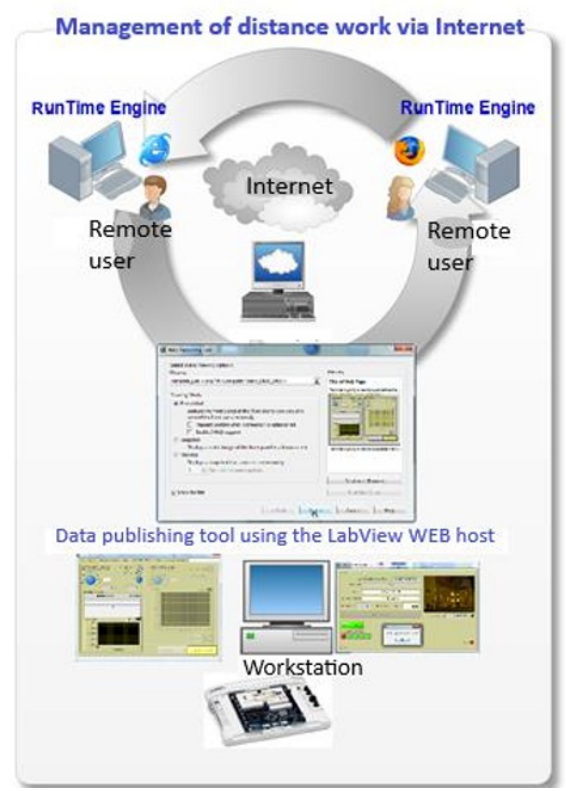
Fig. 5. Distance practical work via